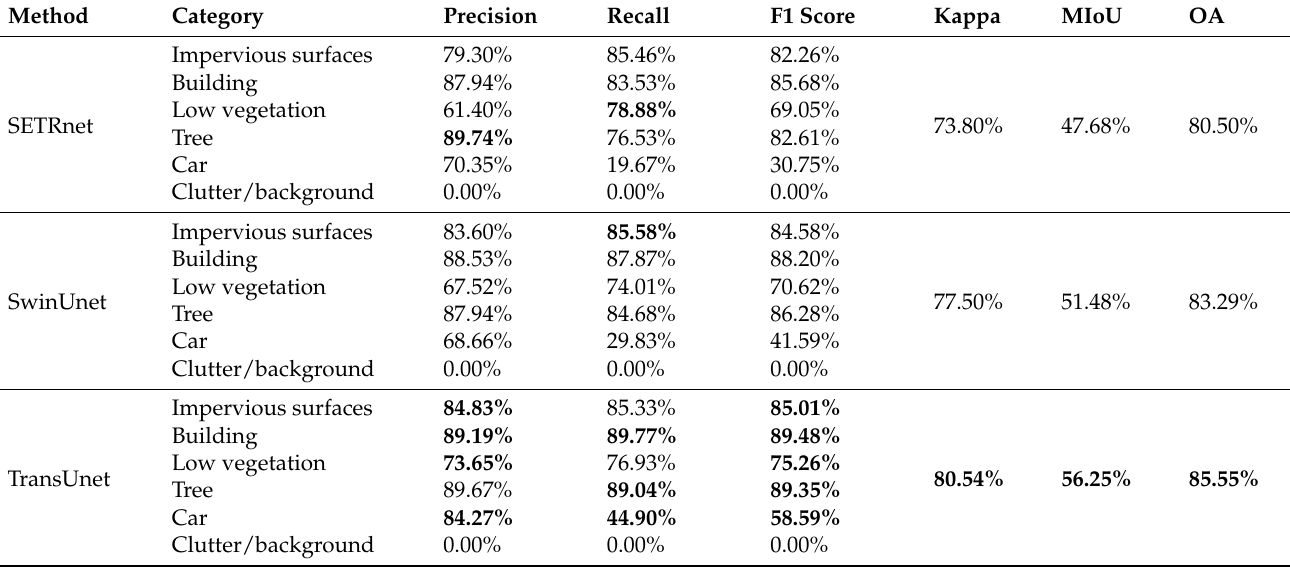
Table 3. Evaluation table of classification results in the Vaihingen data set. The bolded numbers are the models with the best performance in terms of